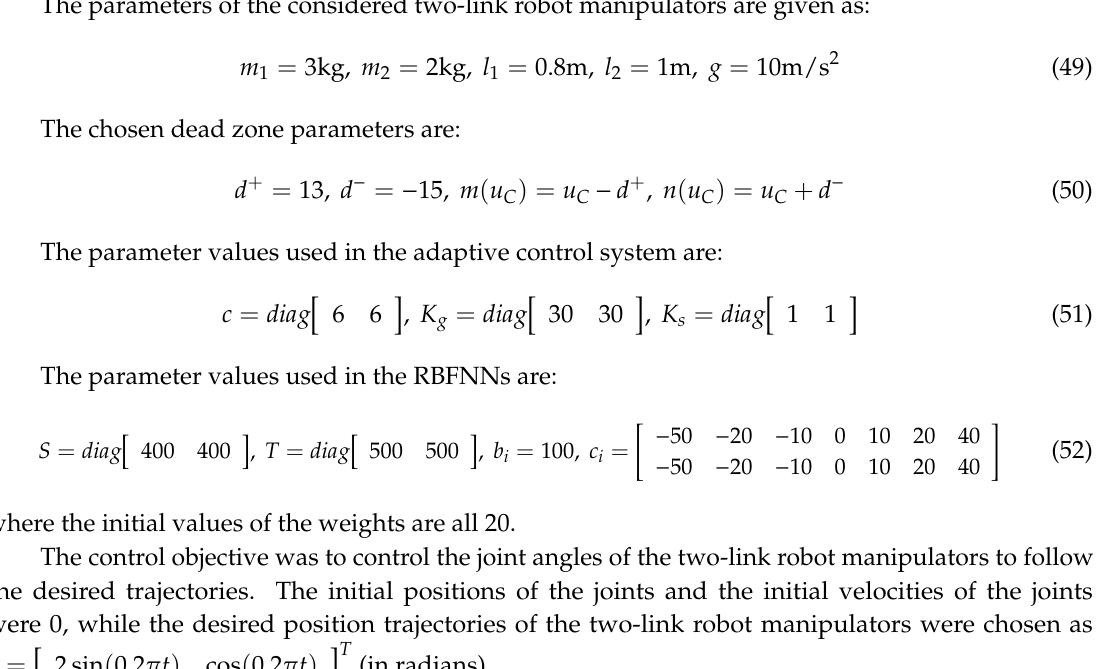
Figure 6. Two-link robotic manipulator model of free form surface grinding robots(FFSGRs). The parameters of the considered two-link robot manipulators are given